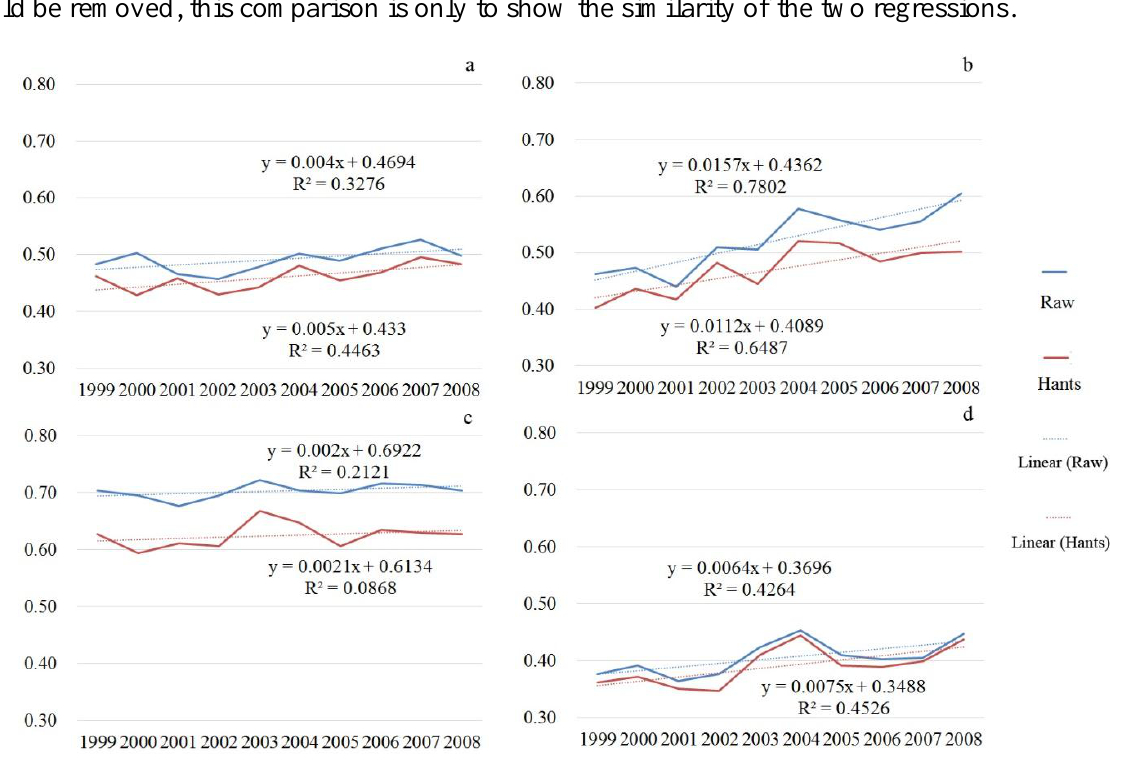
Figure 11. Comparison of the regressed slopes from both raw NDVI and HANTS-filtered NDVI. ( a ) Broadleaf deciduous tree; ( b ) crop; ( c ) needle leaf evergreen tree; and ( d )